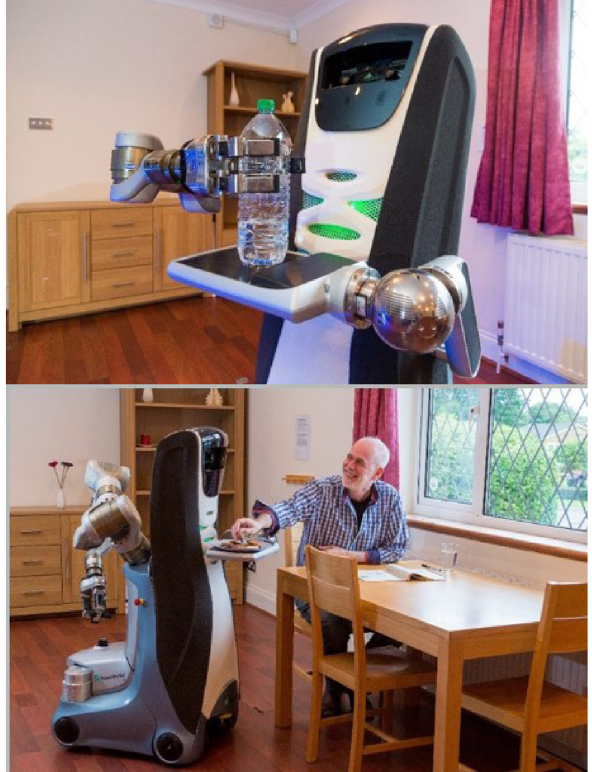
Figure 1: Illustration of Care - O - bot3 ® operating in the UH Robot House. Photography by Pete Stevens,